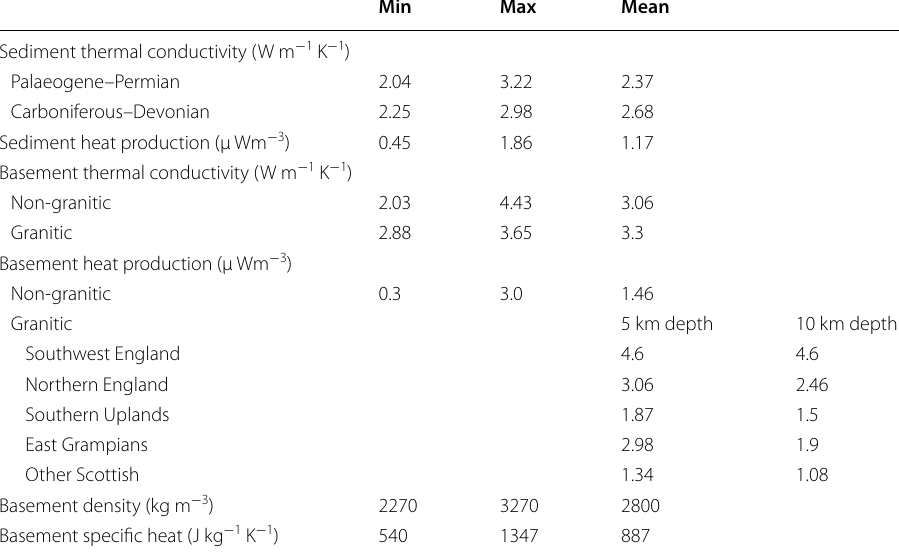
The methodology for the adoption of these properties across the grids of the model are described in the text. It should be noted that the thermal conductivities in the table are at laboratory temperatures and are corrected for temperatures at depth when attributed to the